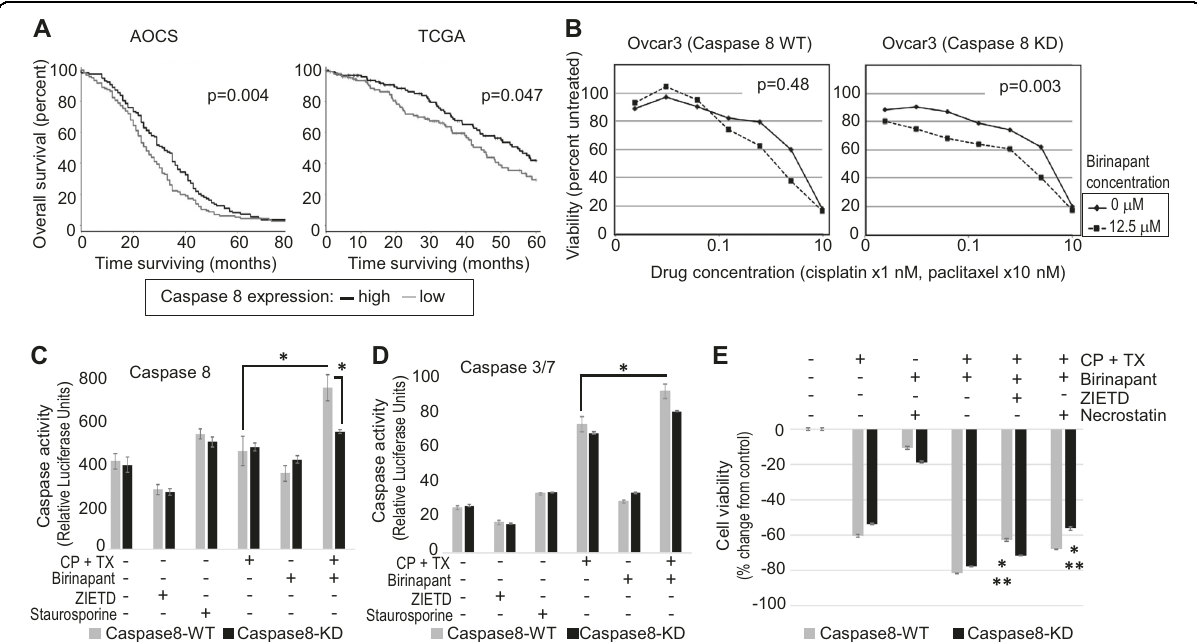
Fig. 1 Low Caspase 8 increases sensitivity of ovarian cancer cell lines to combined chemotherapy treatments. A Overall survival in patients with high (above the median) or low (below the median) Caspase 8 in two datasets shows that low Caspase 8 consistently relates to shorter overall survival. B Ovcar3 cells transduced with either control shRNA (Caspase 8 WT) or Caspase 8 shRNA (Caspase 8 KD) were treated with increasing concentrations of combined cisplatin and paclitaxel in the presence or absence of birinapant (12.5 μ M) for 72 h. Cell viability was measured by XTT assay. Representative results are expressed as average ± S.E.M., n = 4 and shown as percentage of change from vehicle control. C Ovcar3 cells expressing either control (Caspase 8 WT) or Caspase 8 shRNA (Caspase 8 KD) were exposed to combined cisplatin (2.5 µM) and paclitaxel (25 nM) and/or Caspase 8 inhibitor ZIETD (25 µM), birinapant (12.5 μ M), and staurosporine (1 µM) for 18 h to induce caspase activity. Results of Caspase 8 cell- based assay are expressed as average luciferase units ± S.E.M., n = 4. Single asterisk (*) represents p < 0.05 based on t test. D Caspase 3 and 7 activity was measured in the described cell lines and exposed to similar conditions described in C . E Ovcar3 cells expressing either control (caspase 8 WT) or Caspase 8 shRNA (Caspase 8 KD) were exposed for 72 h to combined cisplatin (2.5 µM) and paclitaxel (25 nM), birinapant, 12.5 μ M, and/or ZIETD (25 µM) or NEC1 (25 µM) as indicated. Viability was assessed by XTT assay. Results are expressed as average ± S.E.M., n = 3. Single asterisk (*)